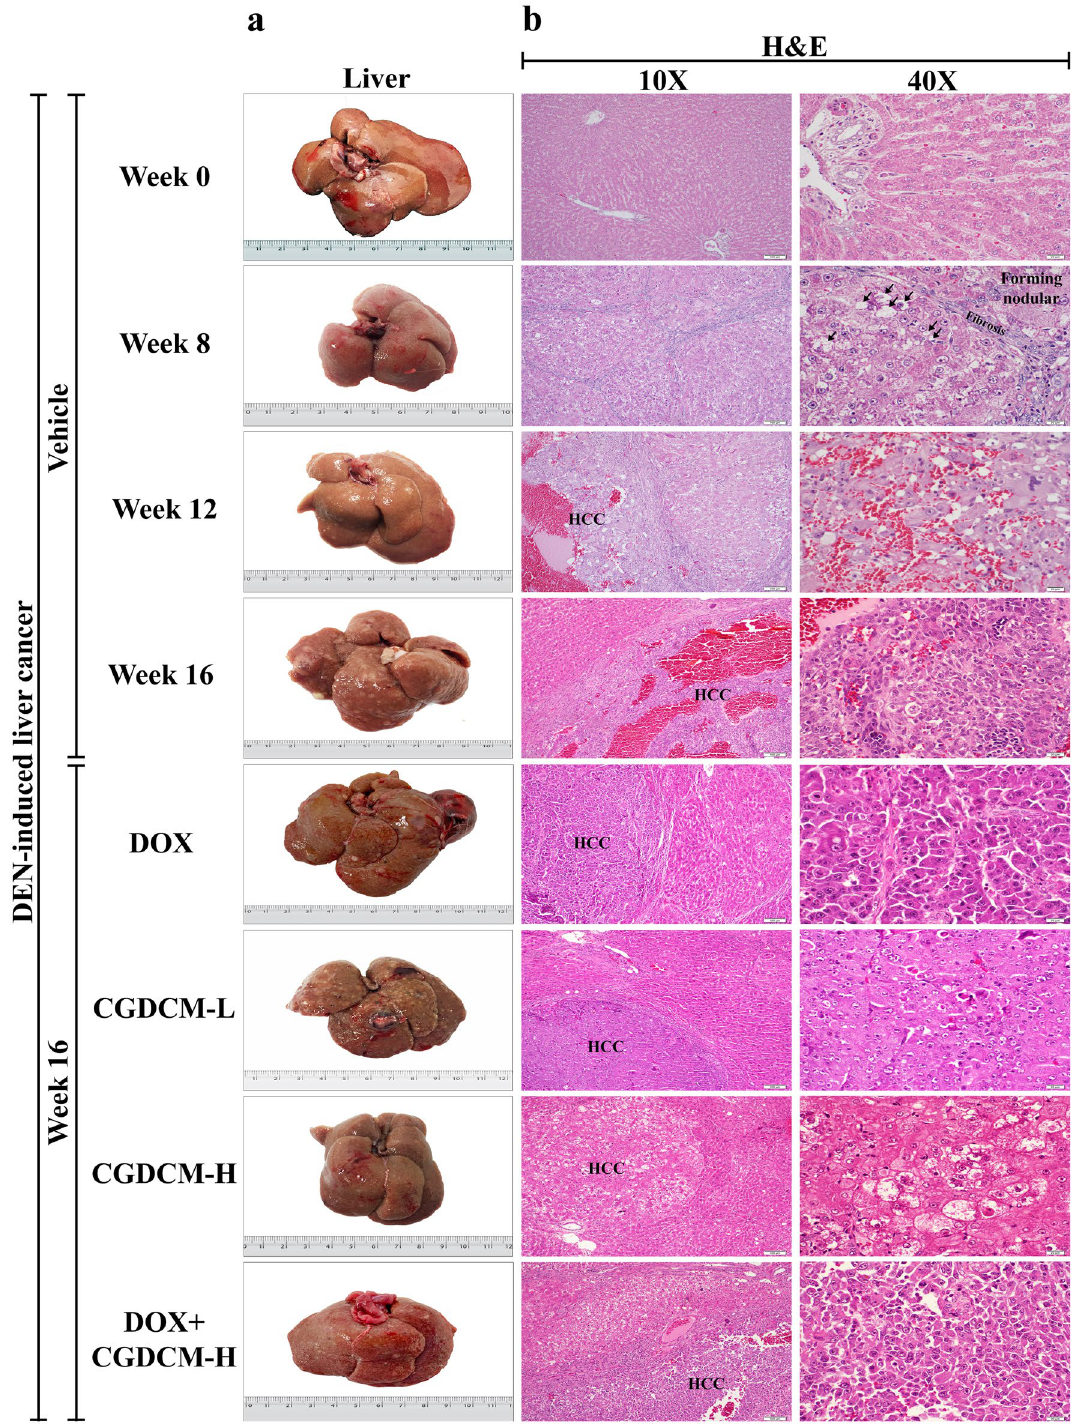
Figure 8. The effect of a combination of DOX and CGDCM extract from stem bark of C. gigantea on the suppression of tumors in DEN-induced liver cancer rats. DEN administration was performed for 8 weeks, and the treatments were performed for 4 weeks from week 12, which included DOX, CGDCM-L, CGDCM-H, and the combination of DOX with CGDCM-H. The vehicle group was treated with 0.8% DMSO. ( a ) Representative photographs of the macroscopic appearance of the liver. ( b ) Representative images of microscopic examination of liver tissues stained with hematoxylin and eosin (H&E), ( c ) Masson’s trichrome staining, and ( d ) immunohistochemical analysis of Ki-67 expression. Bars = 100 µm and 20 µm under × 10 and × 40 magnification visualized by light microscopy. CGDCM , C. gigantea dichloromethane extract; CGDCM-L, CGDCM low dose; CGDCM-H, CGDCM high dose; DOX,